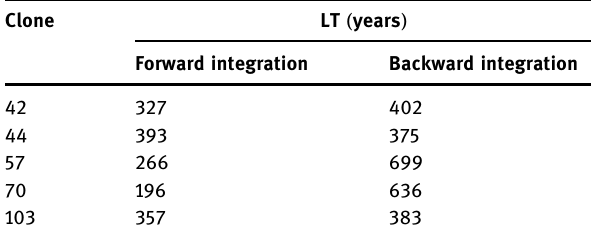
Table 7: Computed values LT of clones of the comet 322P